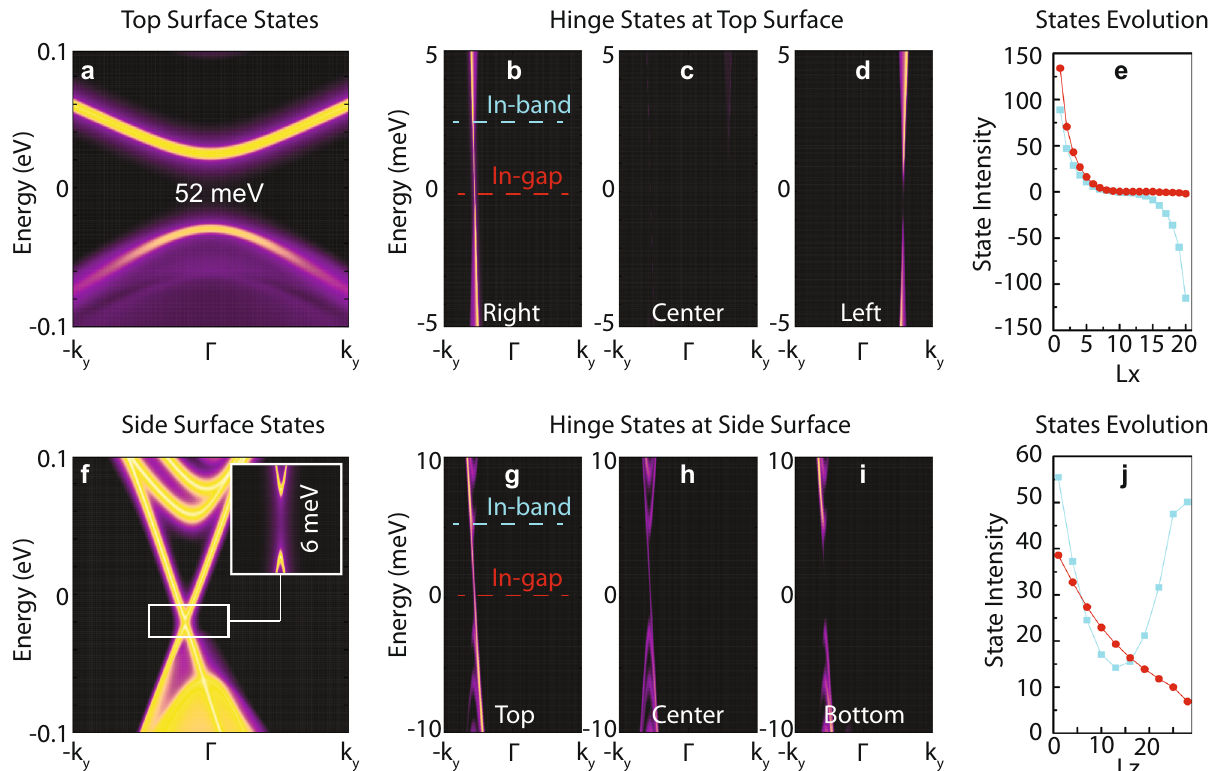
Fig. 4 Real-space evolution of the hinge spectra. Surface states and the evolution of the hinge states through the top surface a – e and the side surface f – j for FM axion insulator MnBi 2 Te 4 . a Top surface states. b – d LDOS of a sample with 20-unit-cell thick in the x -direction, including the right hinge b , center of the top surface c , and the left hinge d . e Intensity of the in-band (blue) and in-gap (red) hinge states projected onto different positions of the top surface as a function of the unit-cell index (#1 and #20 are the hinges, while #10 is the center of the computed cell). f Side surface states. g – i LDOS of a sample with 30-unit-cell thick in the z -direction (i.e., 30 VdW layers), including the top hinge g , center of the side surface h , and the bottom hinge i . j Similar to e but for the side